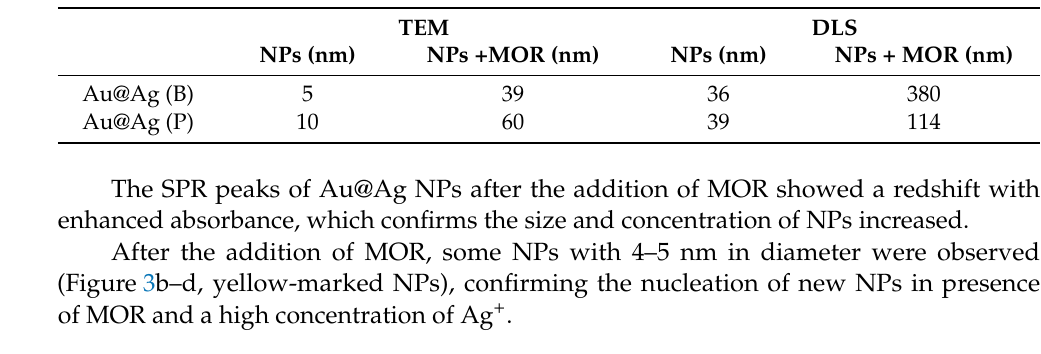
Table 2. TEM and DLS analysis for Au@Ag NPs